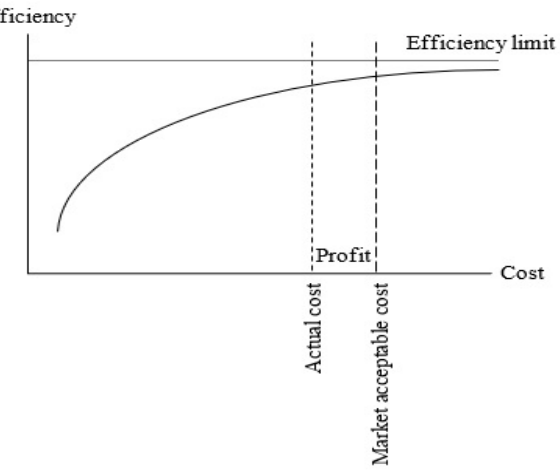
Figure 6. Trade-off between efficiency and cost.